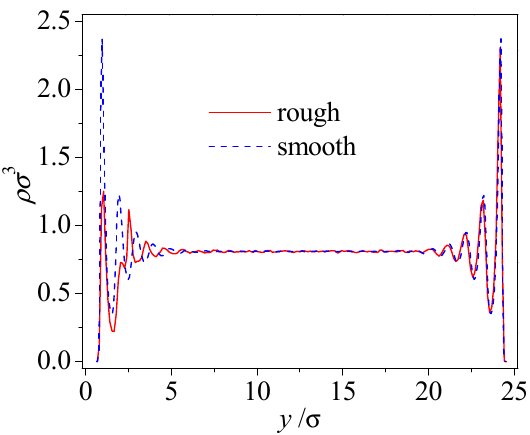
Figure 2. Density distributions in the smooth and rough nanochannels ( ρ w = 2 ρ , ε wl = ε , S = 9.4 σ , δ = 1.57 σ ).